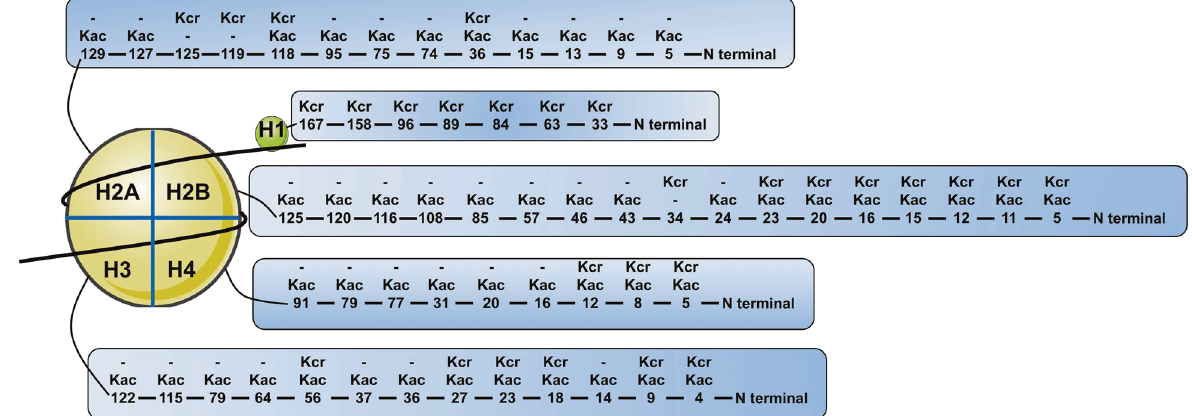
Fig. 4 Distribution of lys crotonylation and acetylation on the fi ve human histones. Illustrations of histone Kcr and Kac sites in human cells. Based on PTMs identi fi ed in (Tan et al . Cell. 2011)